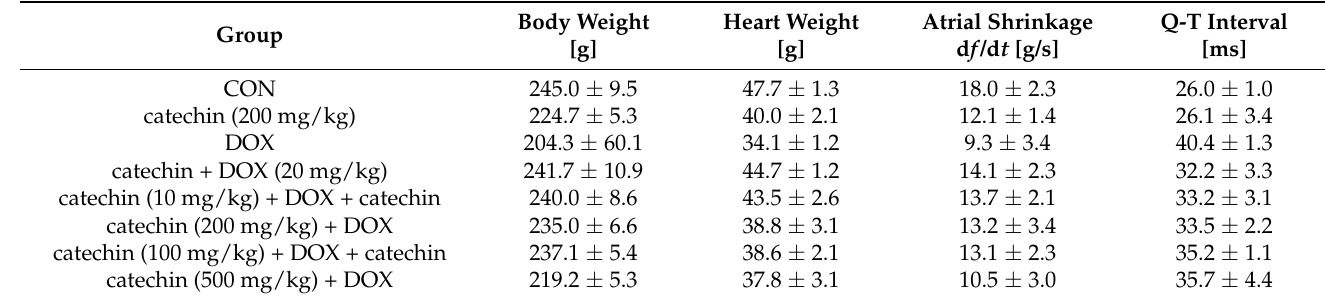
Table 13. Effect of catechin on body weight, heart weight, atrial shrinkage, and Q-T interval in rats treated with DOX at a dose of 3 mg/kg/week for one month